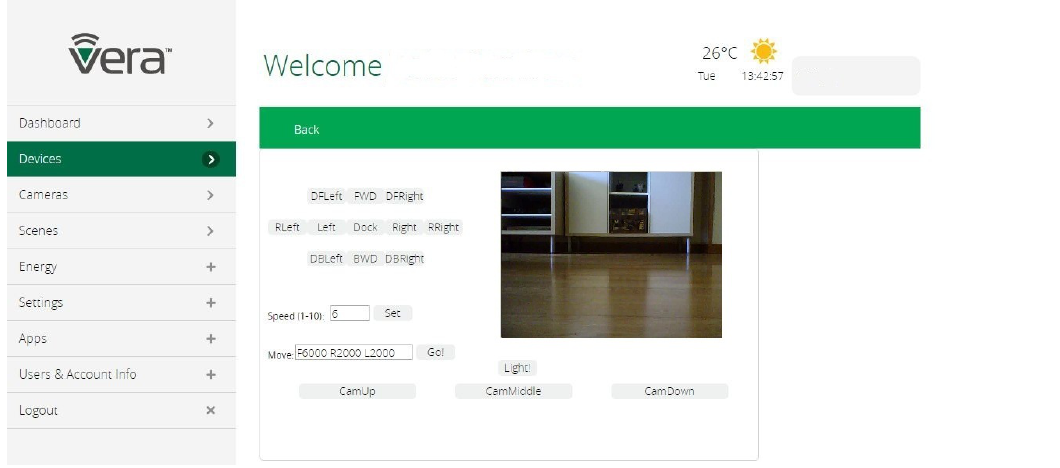
Figure 2. Vera Control Graphical Interface for